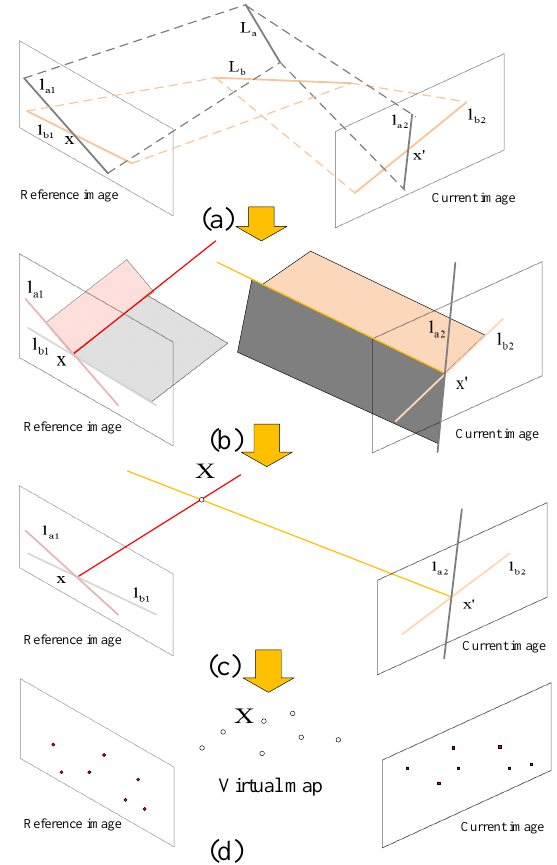
Figure 3. Illustration of the relationship between the matched line segments and the virtual map. The process of generating a virtual map consists of four stages. ( a ) Lines in space are projected onto reference image and current image to get matched line segments. ( b ) Matched lines on image are back projected into space to get two virtual intersection lines. ( c ) Two virtual intersection lines intersect in space to get a virtual 3D point. ( d ) A large number of virtual 3D points constitute a virtual